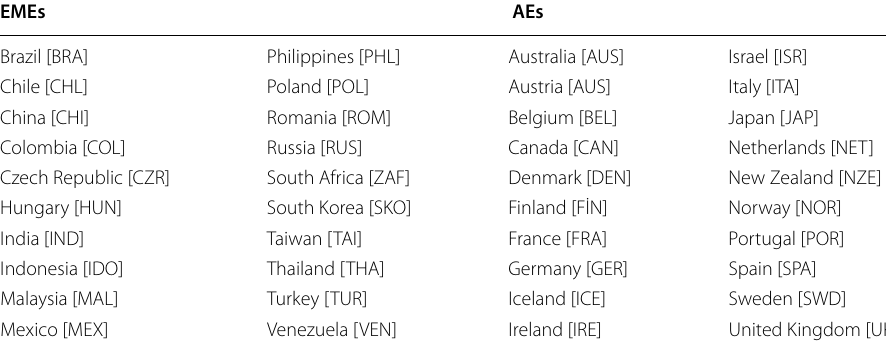
Table 1 Country / region sample